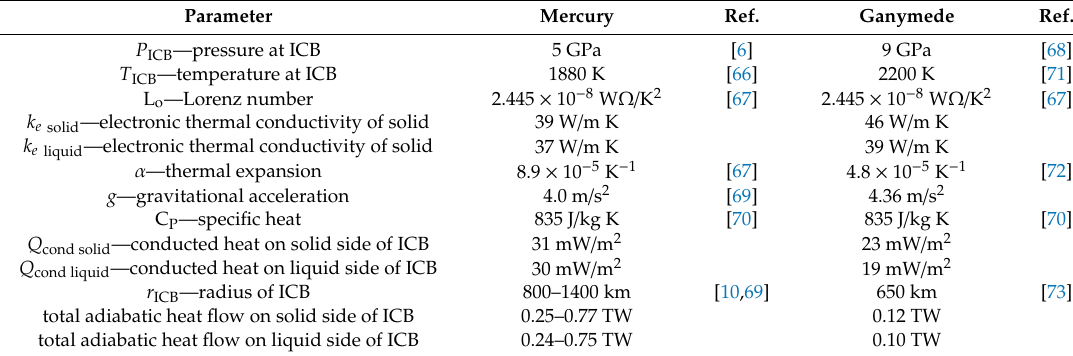
Table 1. Parameter values for Mercury and Ganymede used in heat flow calculations